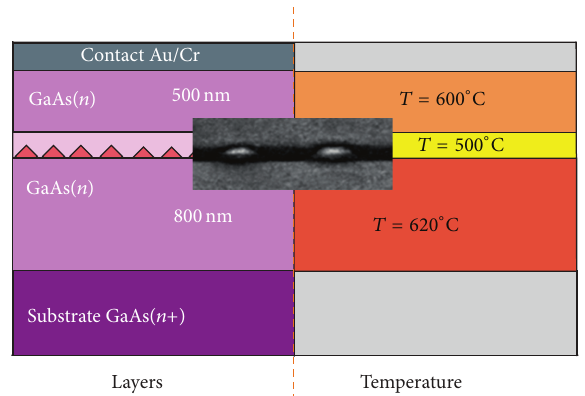
Figure 12: Cross section and temperature map of a sample for CV investigation.